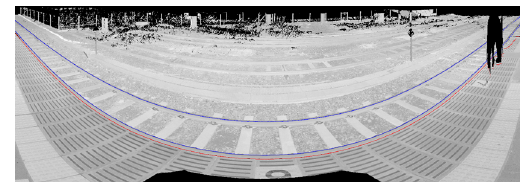
Figure 19. Point data acquired at the measuring station No. 19